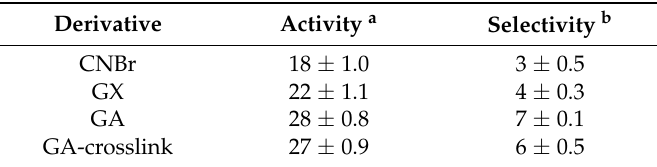
Table 2. Hydrolysis of sardine oil catalyzed by lipase derivatives.